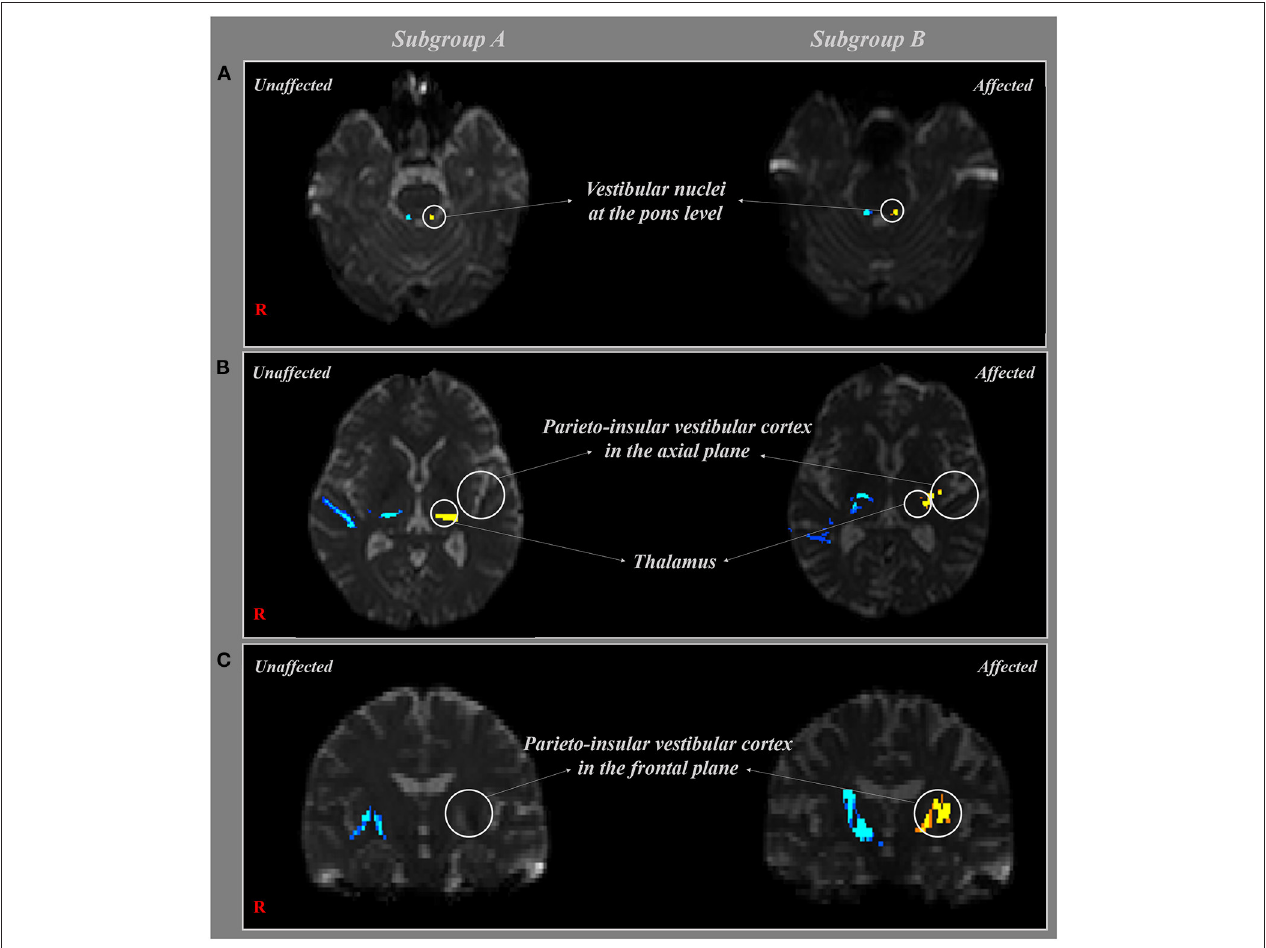
FIGURE 2 | The projection pathway to parieto-insular vestibular cortex (PIVC) is shown at each level. The affected side (yellow and red) and unaffected side (blue) are shown in two subgroups according to the type of diffusion tensor imaging (DTI) tractography. (A) The projection pathway to PIVC that passes by the vestibular nuclei at the pons level, (B) thalamus and PIVC in the axial plane. (C) The projection pathway to PIVC that passes by the PIVC in the frontal